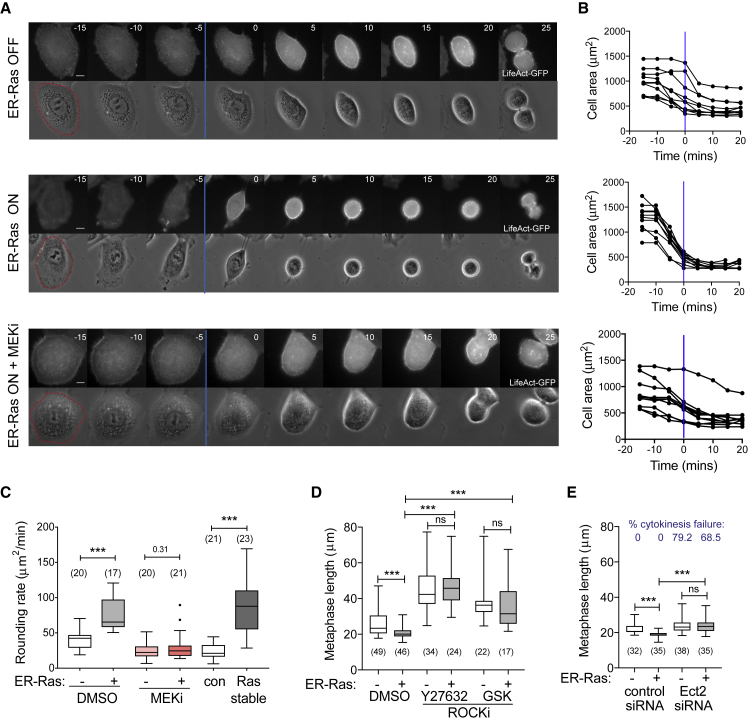
Ras/MEK/ERK Signaling Alters Contractility in Early Mitosis(A) Representative montage time-lapse images of MCF10A ER-hRasV12 cells labeled with LifeAct-GFP following an 8 h treatment with ethanol, 4-OH-tamoxifen, or 4-OH-tamoxifen + 2 μM PD 184352 (MEKi). Time in minutes is aligned so that t = 0 is the frame after NEB (blue line). Scale bars represent 10 μm.(B) Quantification of cell area for 8 cells from conditions in (A) entering mitosis, aligned so that t = 0 is NEB (blue lines). Measurements were taken from time-lapse microscopy of cells 5–15 h after treatment.(C) Boxplot showing rate of area decrease during mitotic rounding for MCF10A ER-hRasV12 cells following 8 h treatment with ethanol or 4-OH-tamoxifen and DMSO or 2 μM PD 184352 as well as control, unsynchronized MCF10A, and MCF10A+hRasv12 cells. p Values calculated using Mann-Whitney ∗∗∗p < 0.001.(D and E) Boxplots showing metaphase cell length for ER-hRasV12 cells following 5–15 h ethanol or 4-OH-tamoxifen treatment and treated with DMSO, 25 μM Y-27632, or 2 μM GSK 269962 (ROCK inhibitors) (D) or scrambled or Ect2 siRNA (E). Ect2 knockdown was verified by analyzing the cytokinesis failure rate (shown in blue). p Values calculated using Mann-Whitney ∗∗∗p < 0.001.